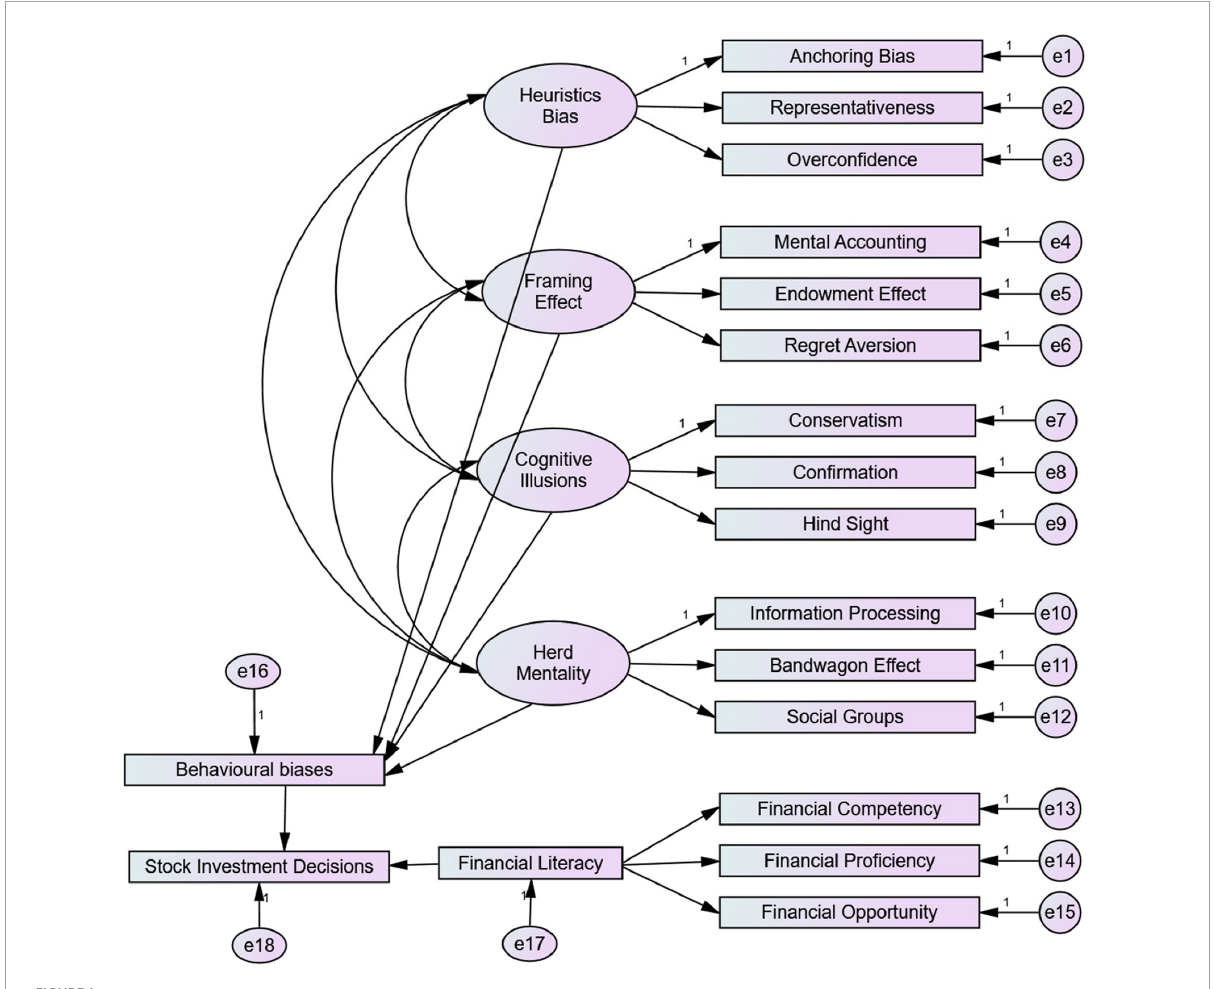
FIGURE1 Measurement